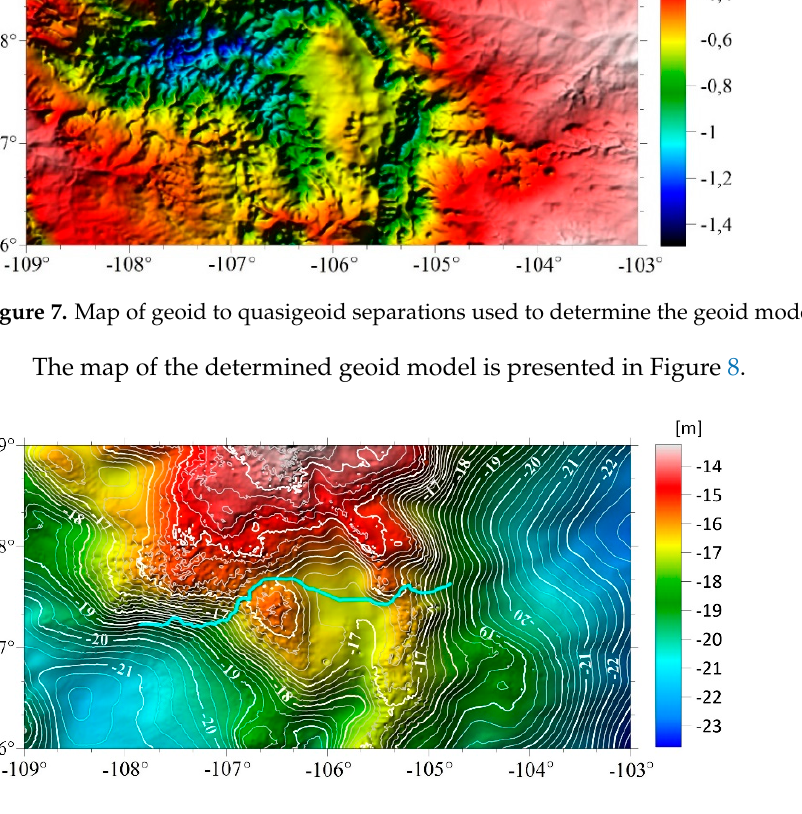
Figure 8. Map of geoid model determined by GGI method. The light blue line is the location of the GSVS17 profile.